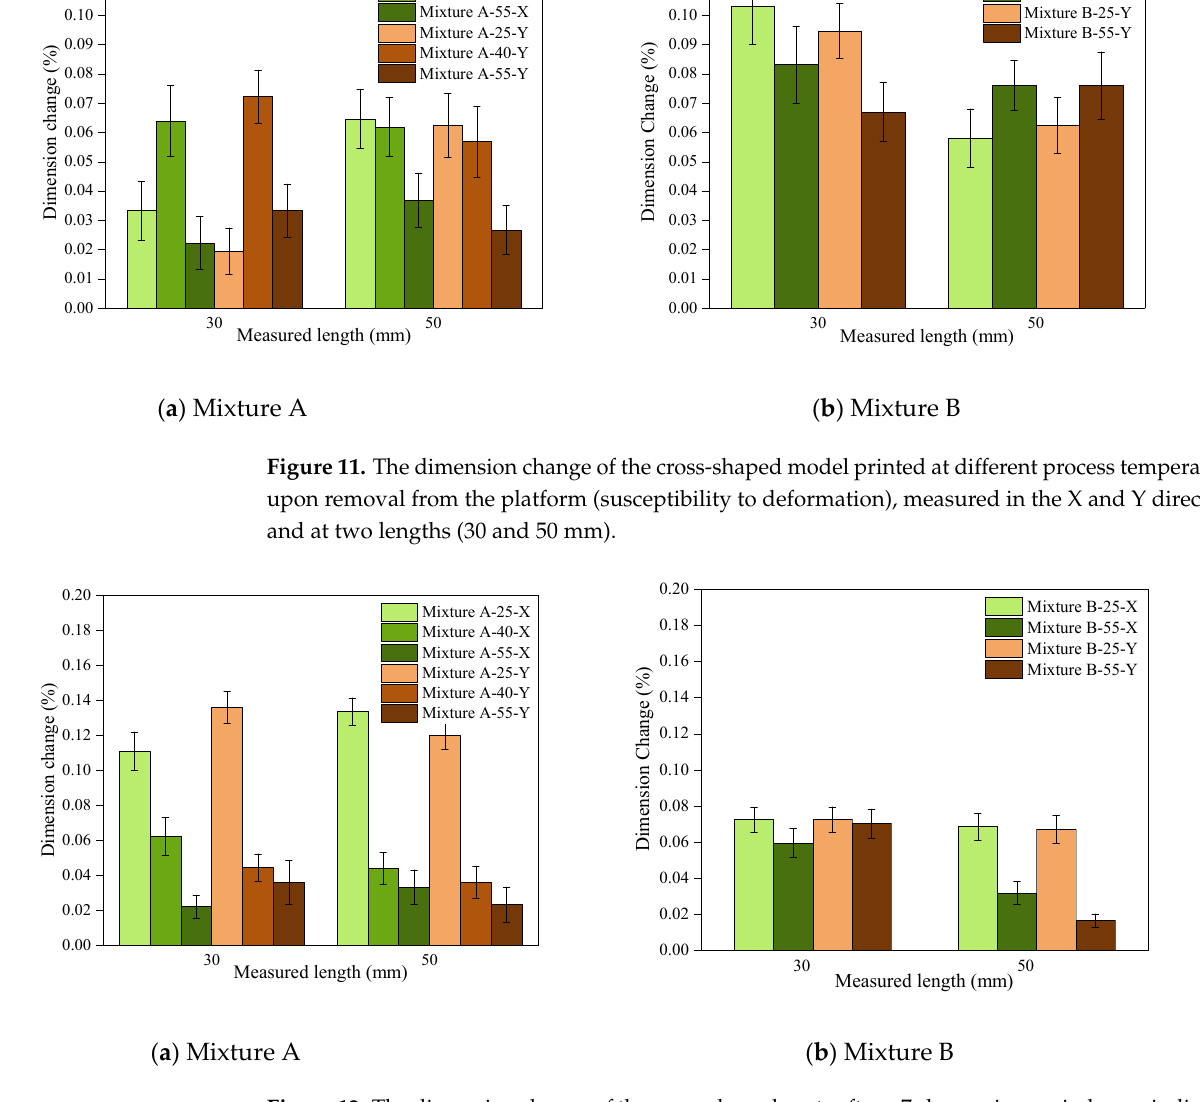
Figure 12. The dimension change of the cross-shaped parts after a 7-day ageing period as an indication of their dimensional stability.